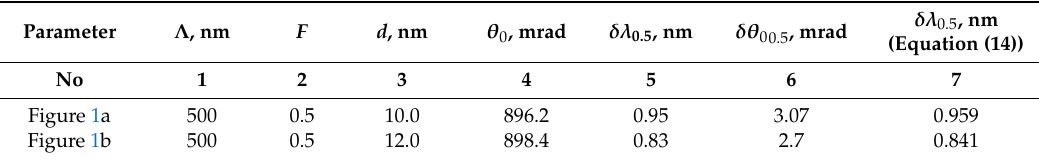
Figure 4. The spectral dependence of the reflection coefficient ( a ) and the angular dependence of the reflection coefficient ( b ). The resonant wavelength is 1.064 µm. The blue color curves correspond to the grating shown in Figure 1a. The red color curves correspond to the grating shown in Figure 1b. The grating parameters and resonant parameters are shown in Table 2. The spectral resonant curve width 𝛿𝜆 0.5 at 0.5 level, given in column 7 of Table 2, was determined by Equation (14) 𝛿𝜆 0.5 = 𝑛 𝛬 𝑐𝑜𝑠 𝑐𝑜𝑠 𝜃 𝛿𝜃 0 0 00.5 . Table 2. Grating parameters and resonant parameters corresponding to the resonant curves are shown in Figure 3.